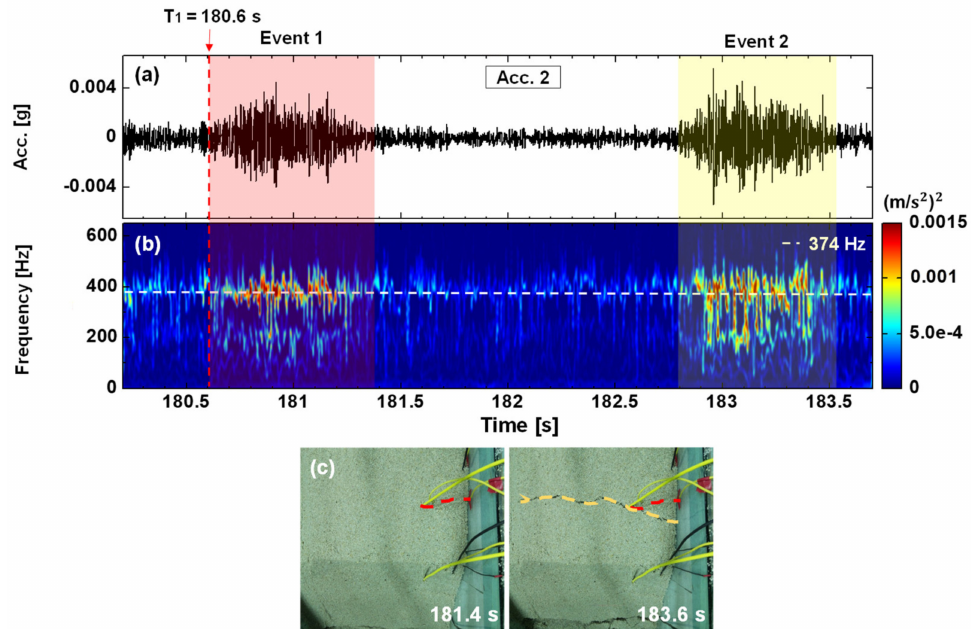
Figure 7. Events 1 and 2, the precursors prior to the Event 3 slide: ( a ) seismic signal, ( b ) time–frequency spectrum, ( c ) top view of the Crack 1 in red dashed line and Crack 2 in orange dashed